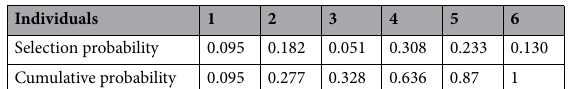
Table 1. Selection probabilities and cumulative probabilities of individuals.